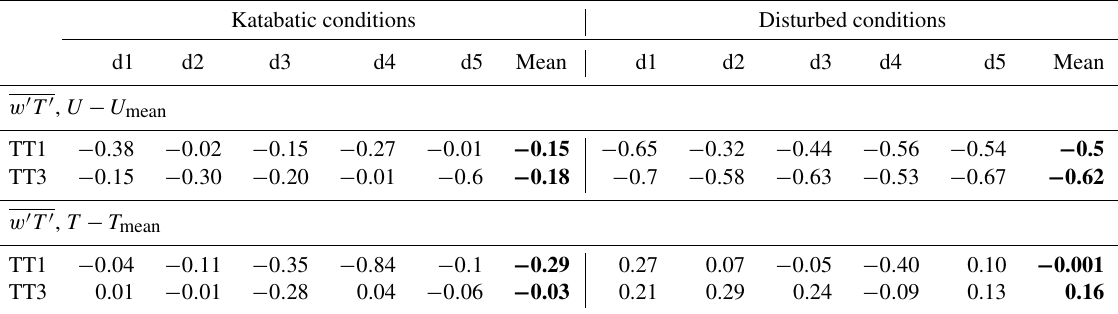
Table 3. Correlation coefficient between (1) vertical turbulent heat flux and wind velocity anomalies and (2) between vertical turbulent heat flux and air temperature anomalies. Values are provided for katabatic and disturbed conditions and for stations TT1 and TT3. Values are provided for days